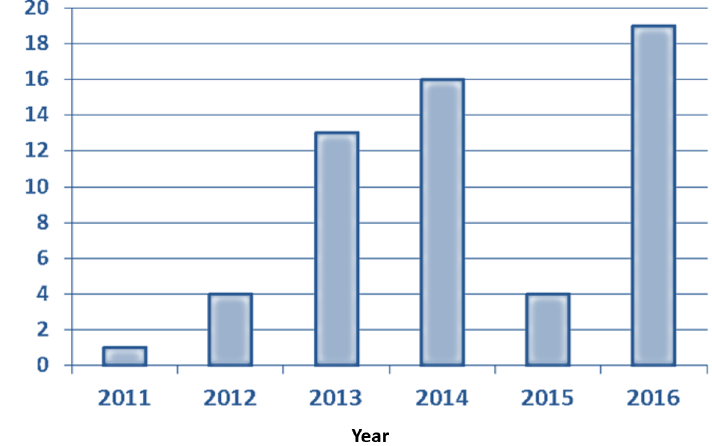
Fig 1. Casesof CRF 19_cpxsubtype over time. Number of CRF19_cpx variants detected in the Hospital Virgen de la Victoria, from the first case found until the end of the study